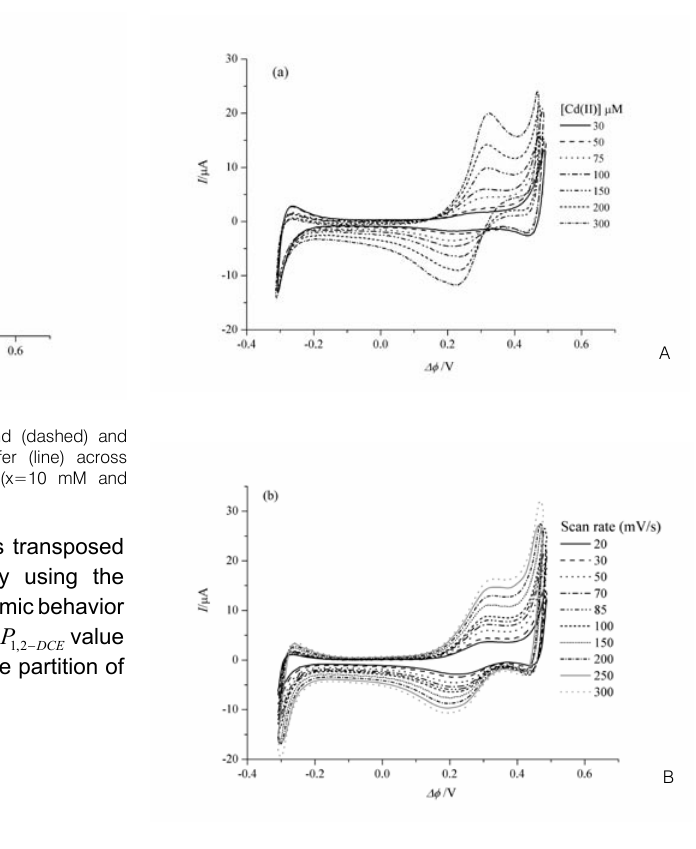
Figure 3. (a) Effect of increasing bulk concentration of metal ion on assisted ion transfer of Cd 2+ across the water/1,2- DCE interface (x=10 mM and v =50 mV s -1 ); (b) The voltammograms of the MAPPT-assisted Cd 2+ transfer at different scan rates (x=10 mM and y=100 μM)